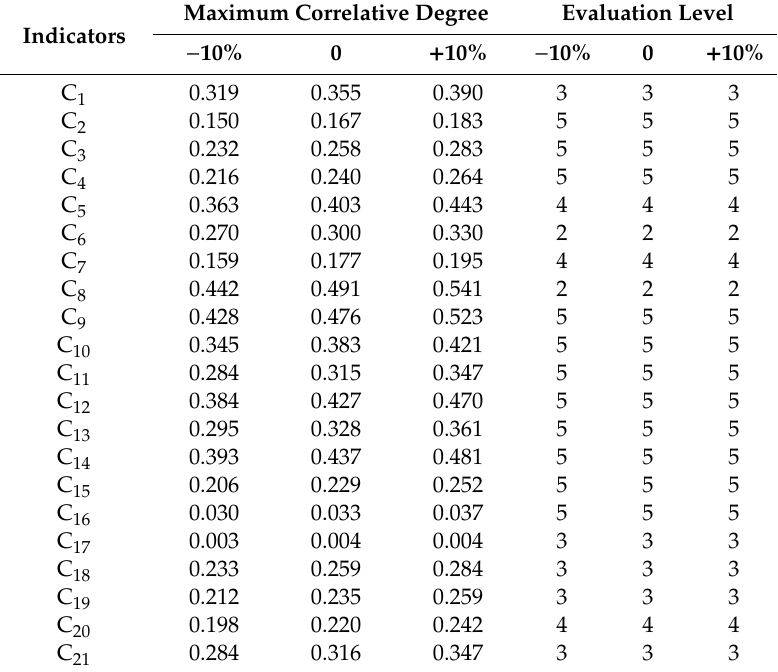
Table 6. Index sensitivity analysis